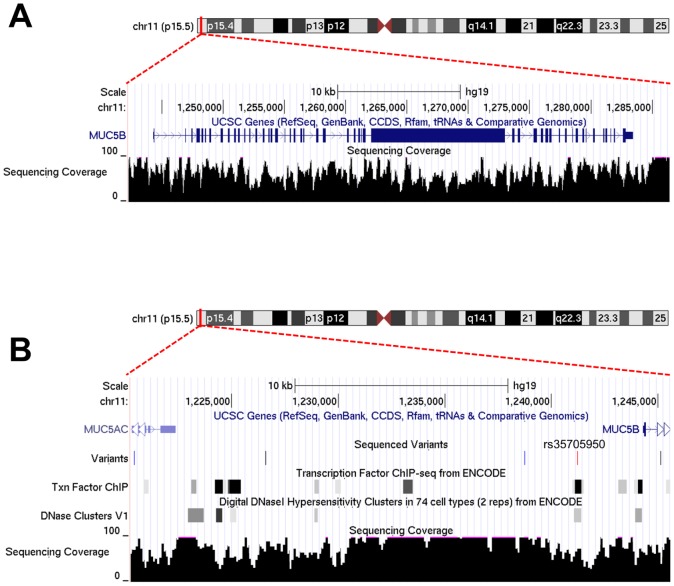
Sequencing coverage and variant distribution within the MUC5B locus.(A) Sequence coverage of the MUC5B gene. (B) Rare variants neighboring the MUC5B promoter variant rs35705950. Variant track is colored by allele frequency (blue: AF<2%, red: AF<5%, black: AF<10%). No other rare variants in this region overlap with putative transcription factor binding sites, consistent with the hypothesis that the rs35705950 is causative of MUC5B dysregulation. Plots were generated using the UCSC genome browser (http://www.genome.ucsc.edu).